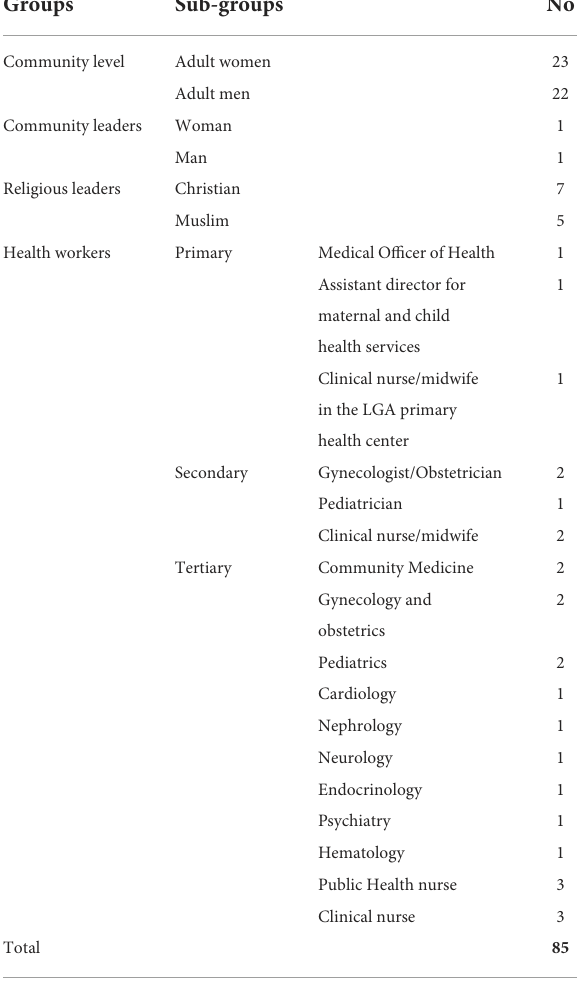
TABLE 1 Distribution of the study